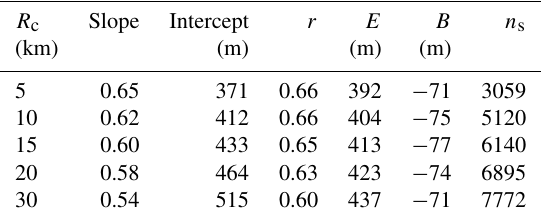
Table 3. Slope, intercept, correlation coefficient r , RMSE E , bias B and number of samples n s resulting from comparing z base and ˆ z base retrievals for different radii of the MISR circular area around the ceilometer stations. These values are obtained for the year 2008 applying a required minimum number of cloud pixels of N = 10 and the 15th percentile to the z